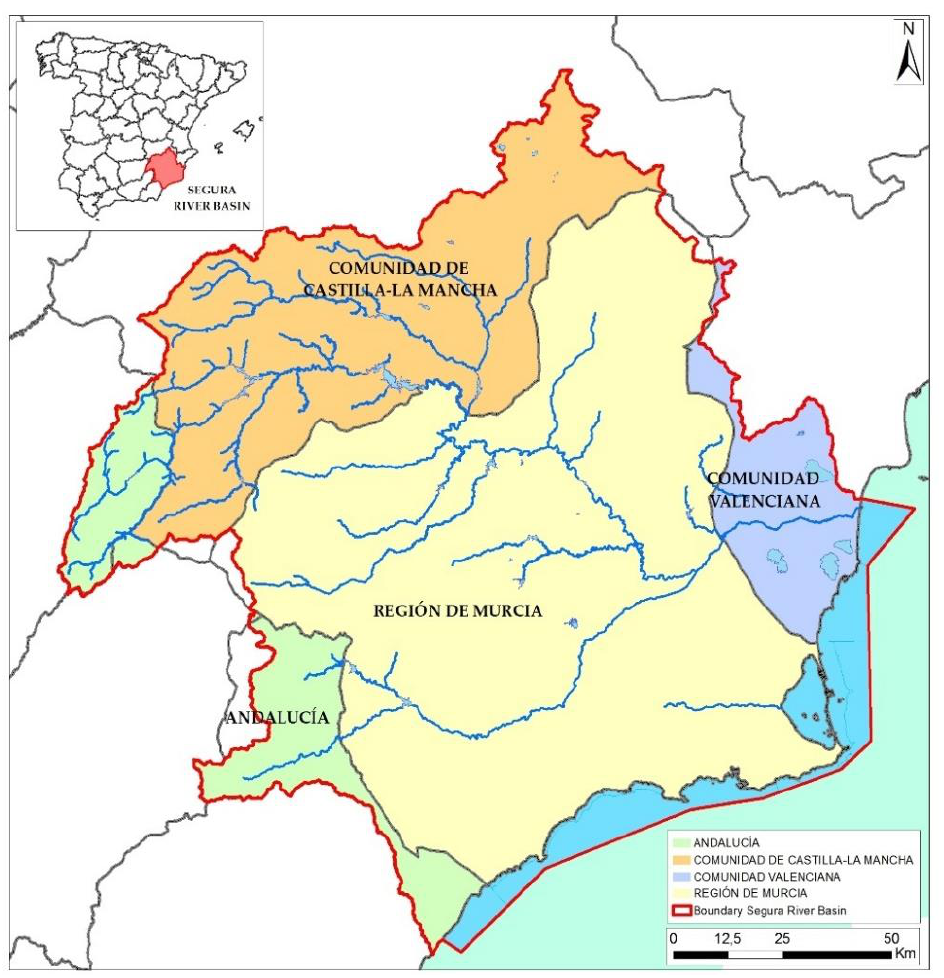
Figure 1. Study situation map. Source: Special Drought Plans, Own elaboration.